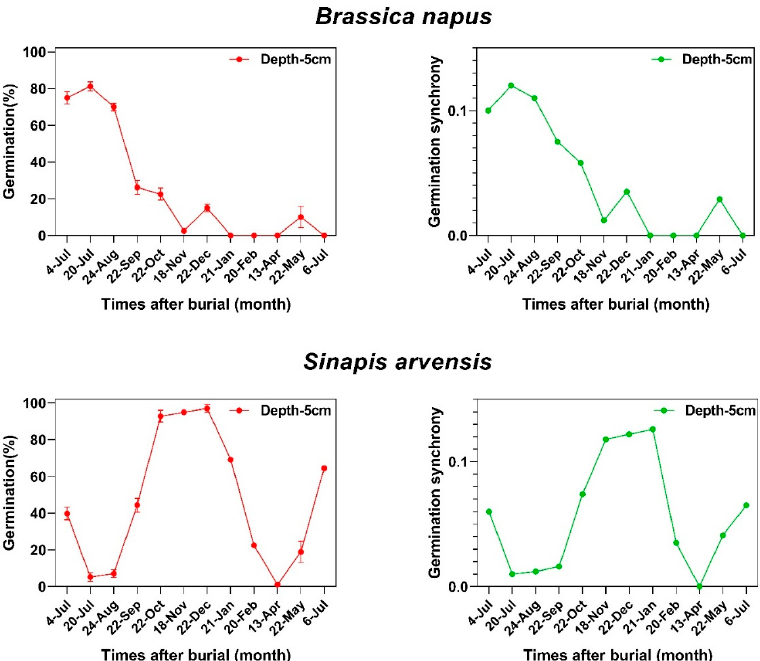
Figure 2. The relationship between germination behavior of two species belonging to Brassicaceae family in the soil seedbank and synchrony patterns.